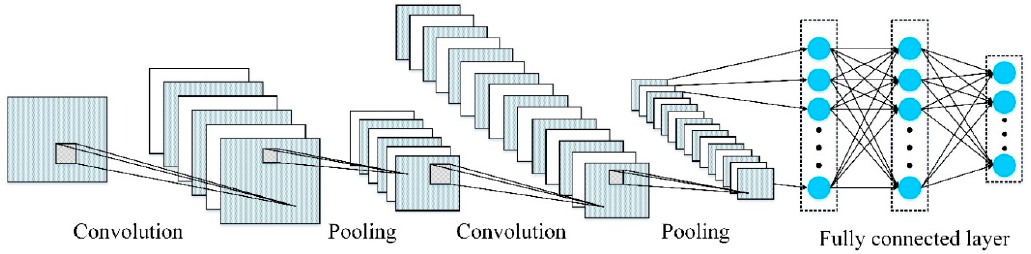
Figure 6. Structure of the convolutional neural network (CNN).